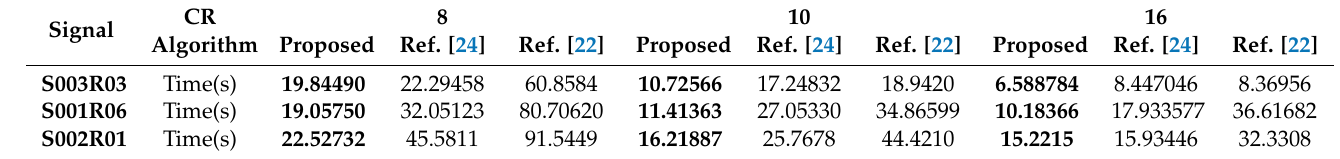
Table 5. Processing time of the proposed and existing techniques in seconds for EEG